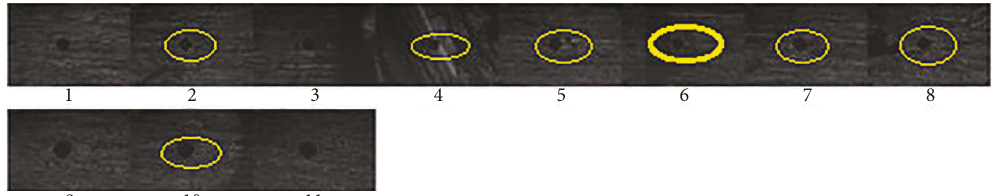
Figure 16: Vickers microhardness indentations: (Cu-AS) side: points 1–3 base metal area, points 3–6 HAZ and TMAZ, point 6 Al-Cu interface area (weld joint area), (Al-RS) side: points 6–9 TMAZ and HAZ, and points 9–11 base metal area (Al).